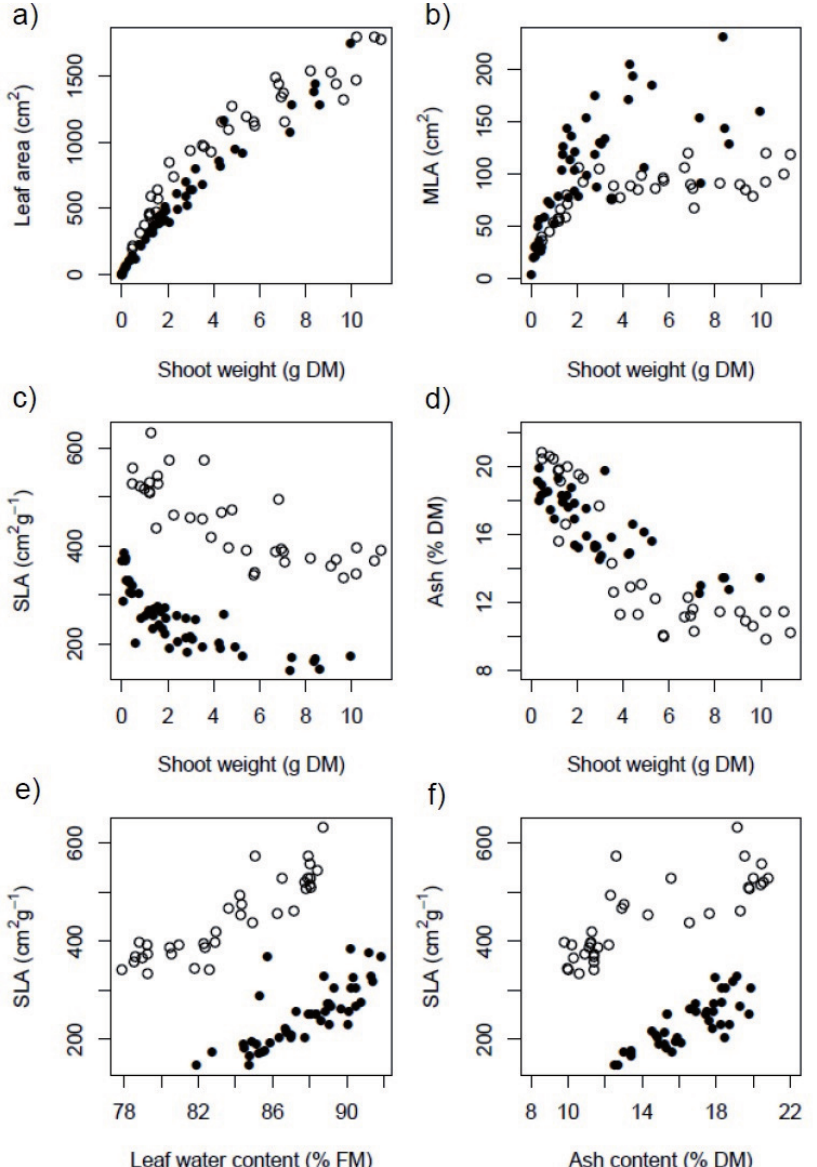
Fig. 3: Relationships between shoot mass and leaf area (a), mean leaf size (b), specific leaf area (c) and ash content (d) and relationships between specific leaf area and leaf water (e) and ash (f) contents in S. hermaphrodita ( ○ ) and S. perfoliatum ( ● ) across different accessions determined at three consecutive harvests during the establishment phase (78, 92 and 106